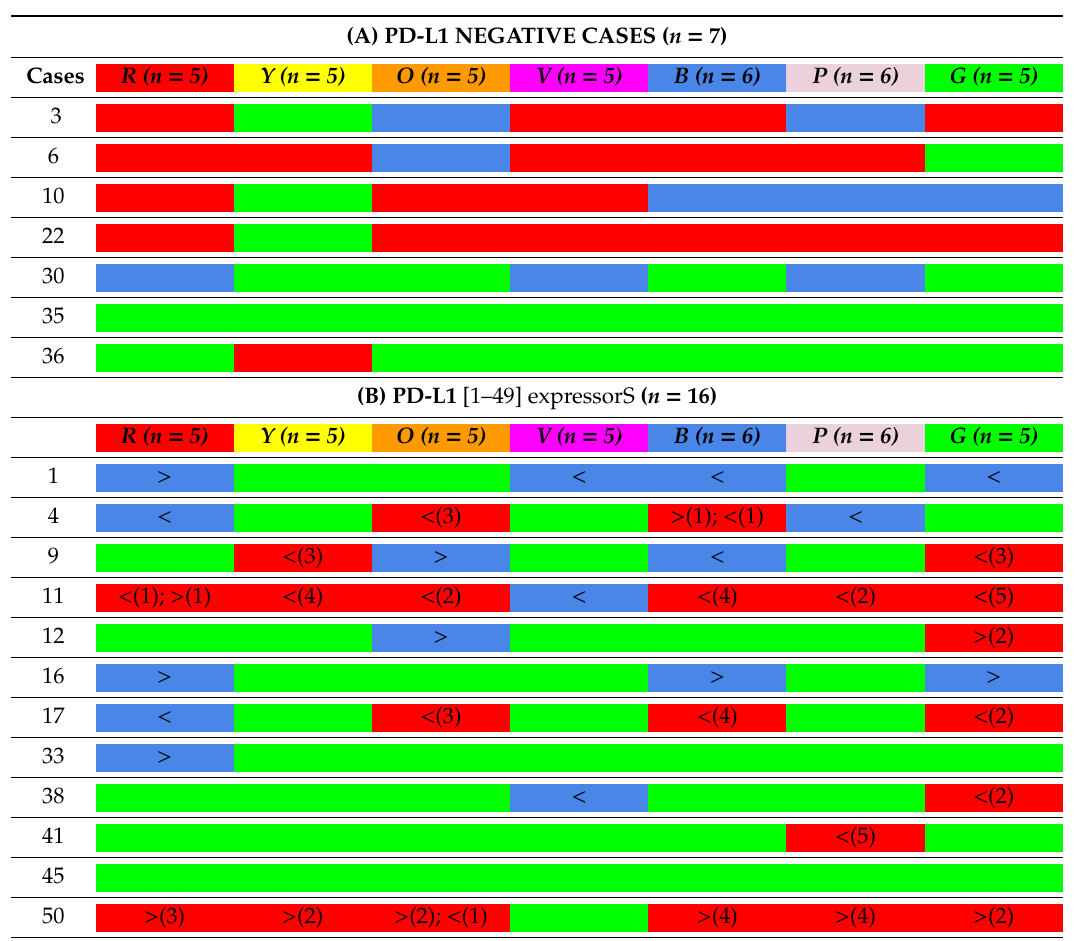
Table 3. Cases are divided according to three cut-o ff : PDL1 negative, intermediate and strong expressors with the aim of highlighting the most challenge